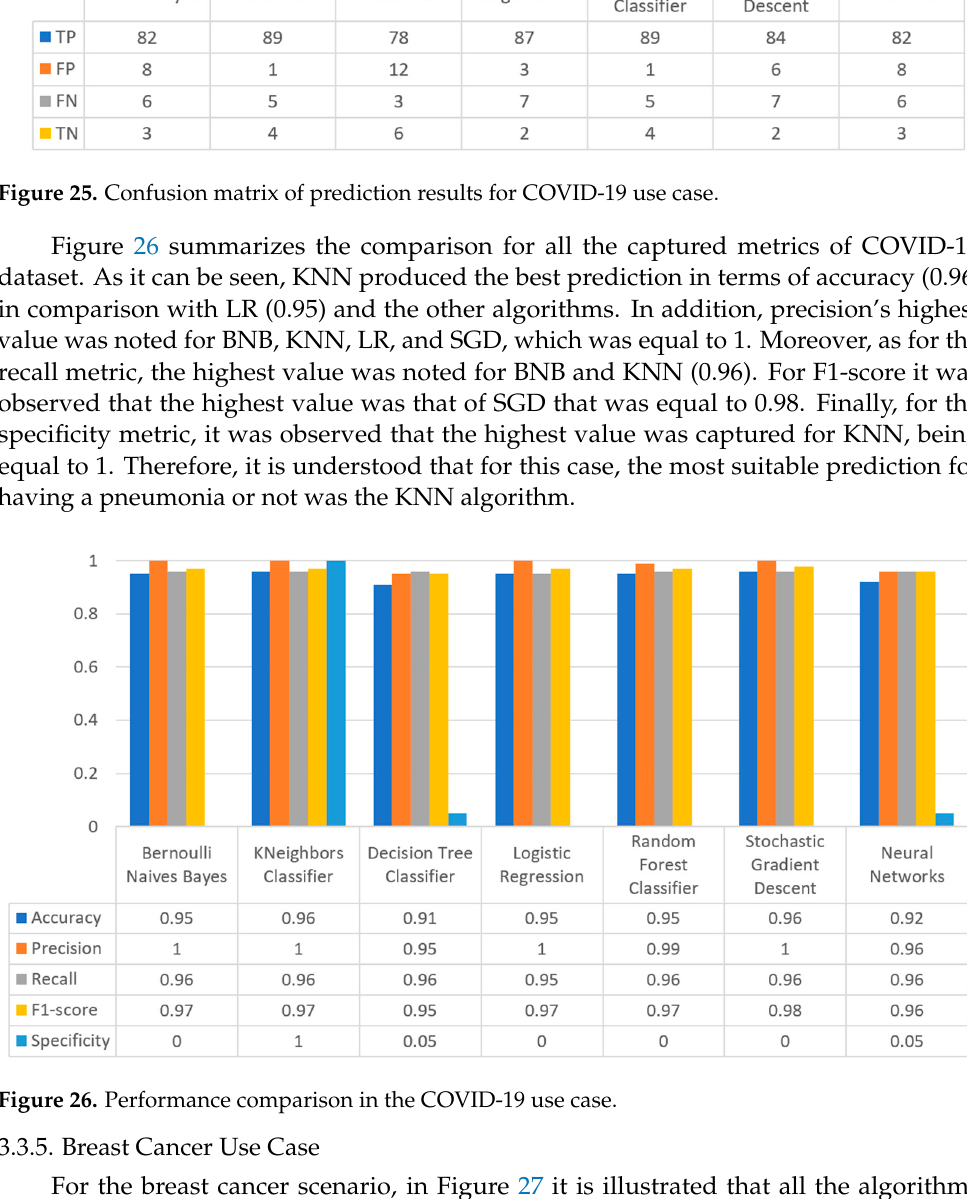
Figure 27. Train–validation–test score for breast cancer use case.